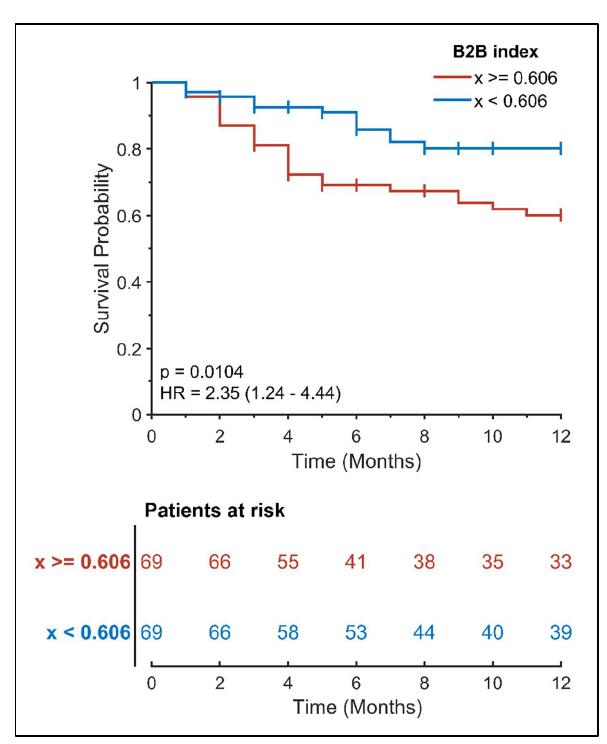
Figure 1. Kaplan-Meier curve for freedom from AF after AF ablation according to pre-ablation B2B index. Table 4. ECG parameters comparison.